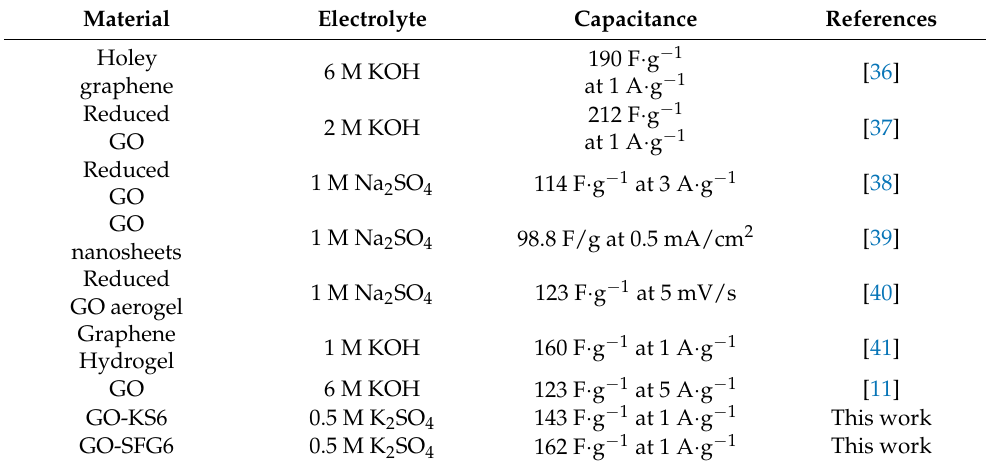
Figure 5. ( a , b ) The capacitive contribution of GOKS6 at different scan rates; ( c , d ) the capacitive contribution of GO-SFG6 at different scan rates. Table 3. The performance comparison of GOs-based-derived electrodes under a three-electrode system in aqueous